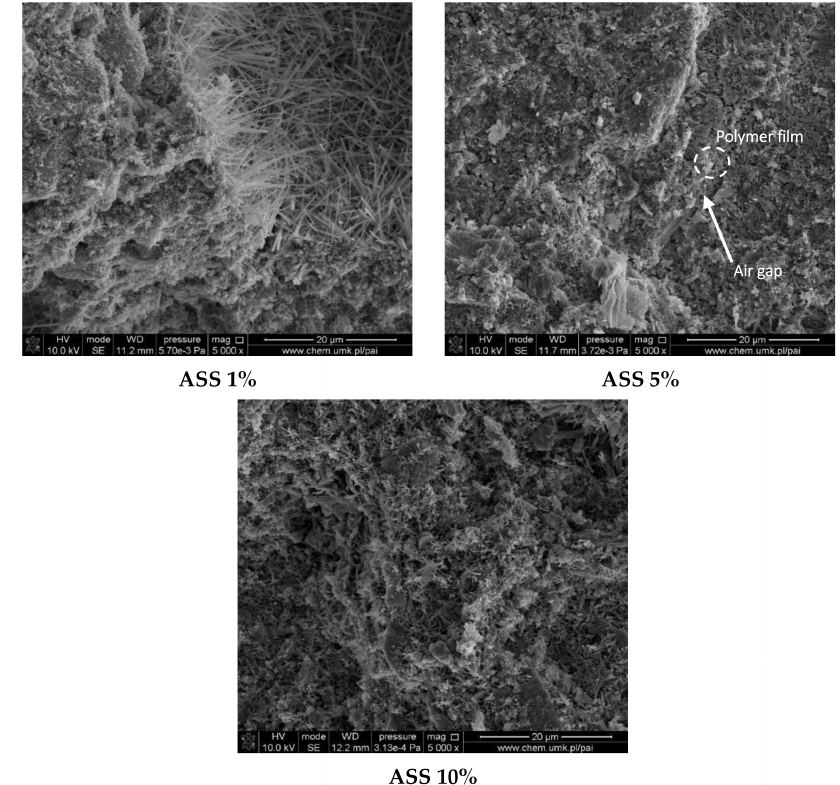
Figure 7. SEM microstructure of concrete with an addition of ASS (1%, 5%, 10%).